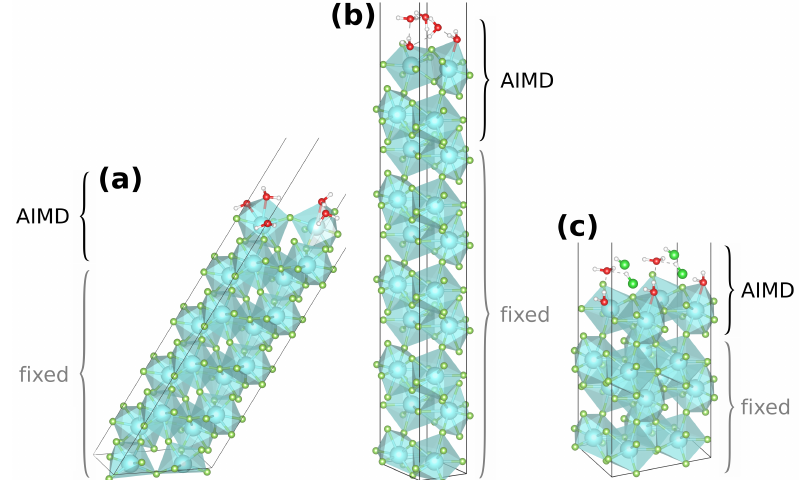
Figure 2. Generic AIMD start structures of the pure monolayer setups of (011) · (H 2 O) ( a ) and (010) · H 2 O ( b ), as well as of the mixed monolayer setup of (010) · HCl:H 2 O ( c ); the region of atoms not fixed (top four YF 3 and adsorbates) is labeled